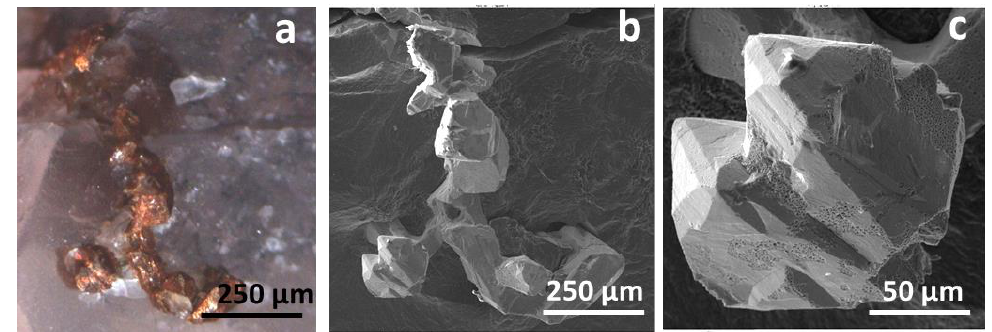
Figure 3. The dendrites of native copper on the surface of a fragment of rock. ( a ) Photo by G. Palyanova, ( b , c ) SEM micrographs.